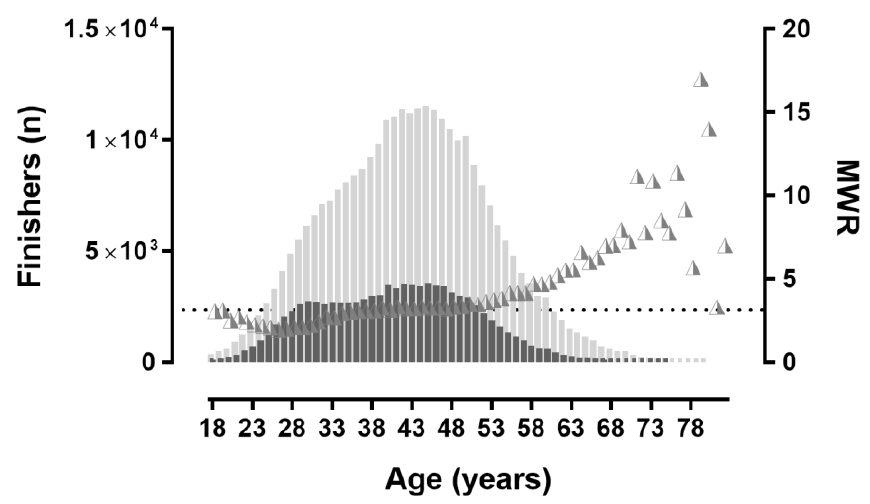
Figure 5. Finishers by 1-year age groups. MWR = men-to-women ratio. The horizontal dashed line shows the overall MWR.